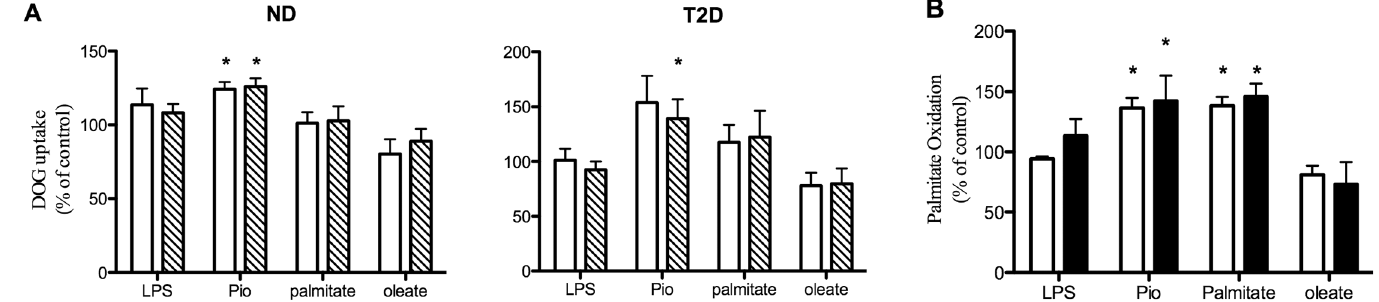
Fig 3. Regulation of metabolism by treatments that influence myokine secretion. Cells were treated as described in Fig 2, but for 48 hr before assay. (A) Basal (open bars) and insulin-stimulated (hatched bars, 33 nM, 60 min) 2-deoxyglucose uptake. Results expressed relative to untreated control, either basal or insulin-stimulated, in each individual set of cells, average + SEM, n = 9 for ND, 8 – 10 for T2D. (B) Palmitate oxidation in ND (open bars, n = 3) and T2D (solid bars, n = 5 – 6) hSMC. * p < 0.05 vs paired